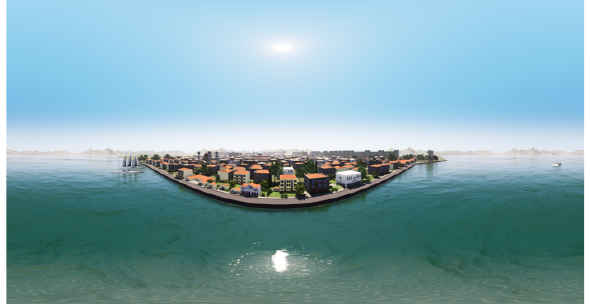
Figure 10. Panoramic image for VR mobile applications of